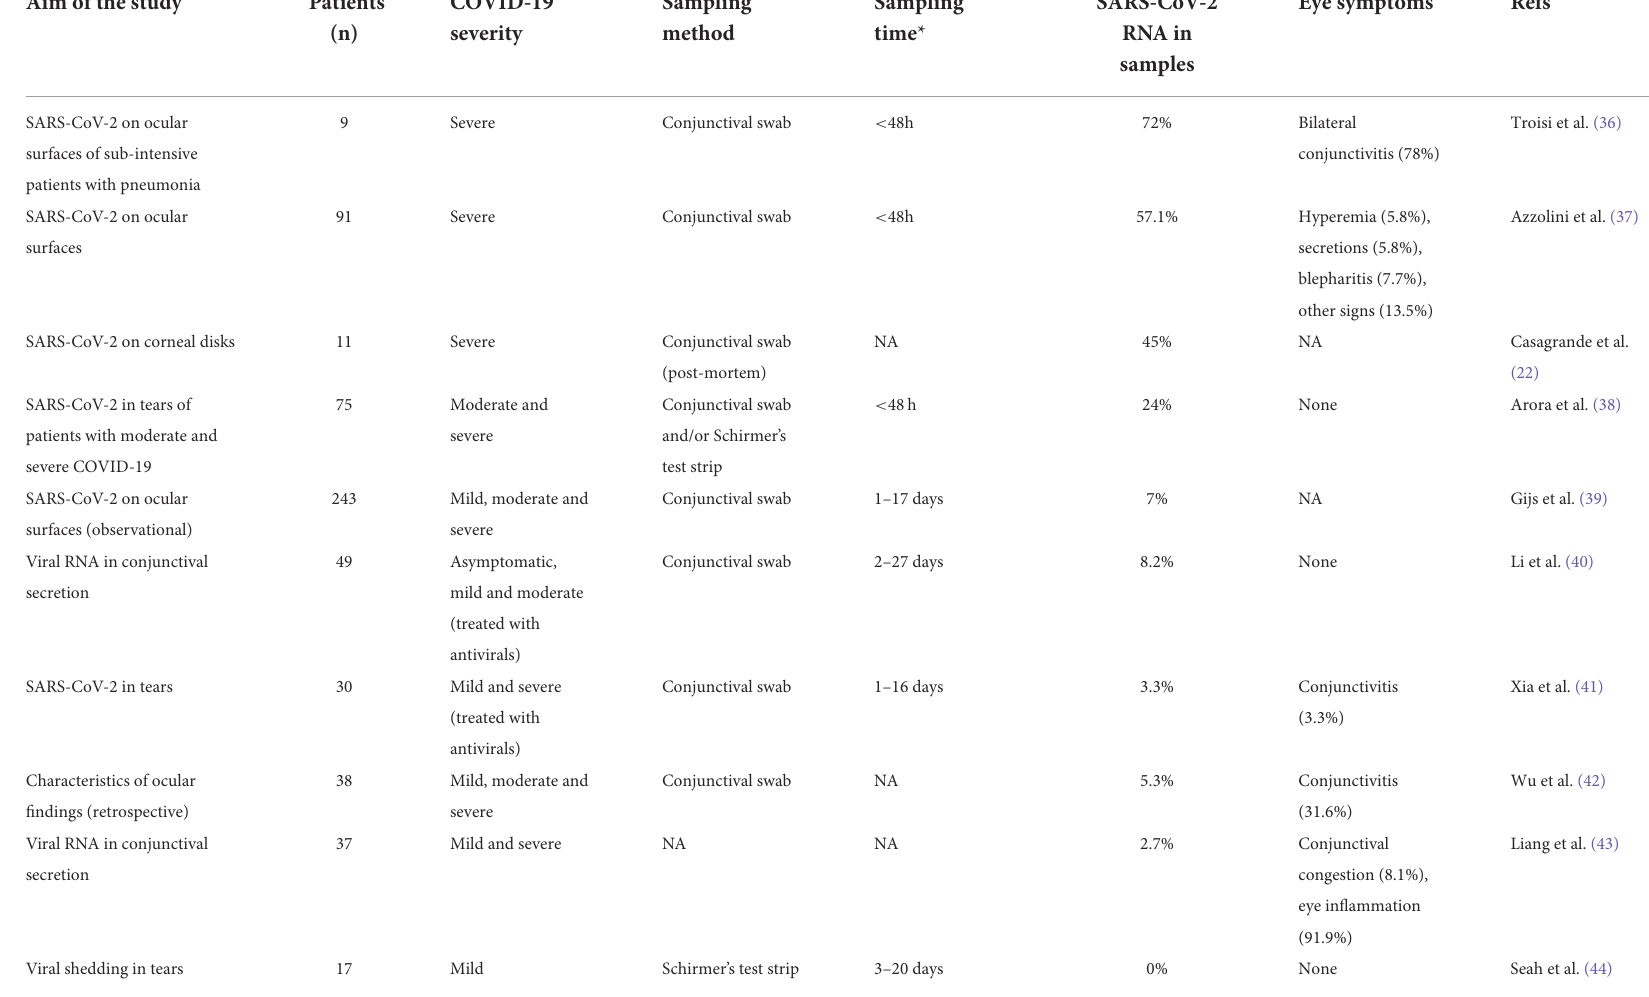
TABLE 1 Overview of relevant literature data investigating SARS-CoV-2 in tears/tear film of infected patients. Aim of the